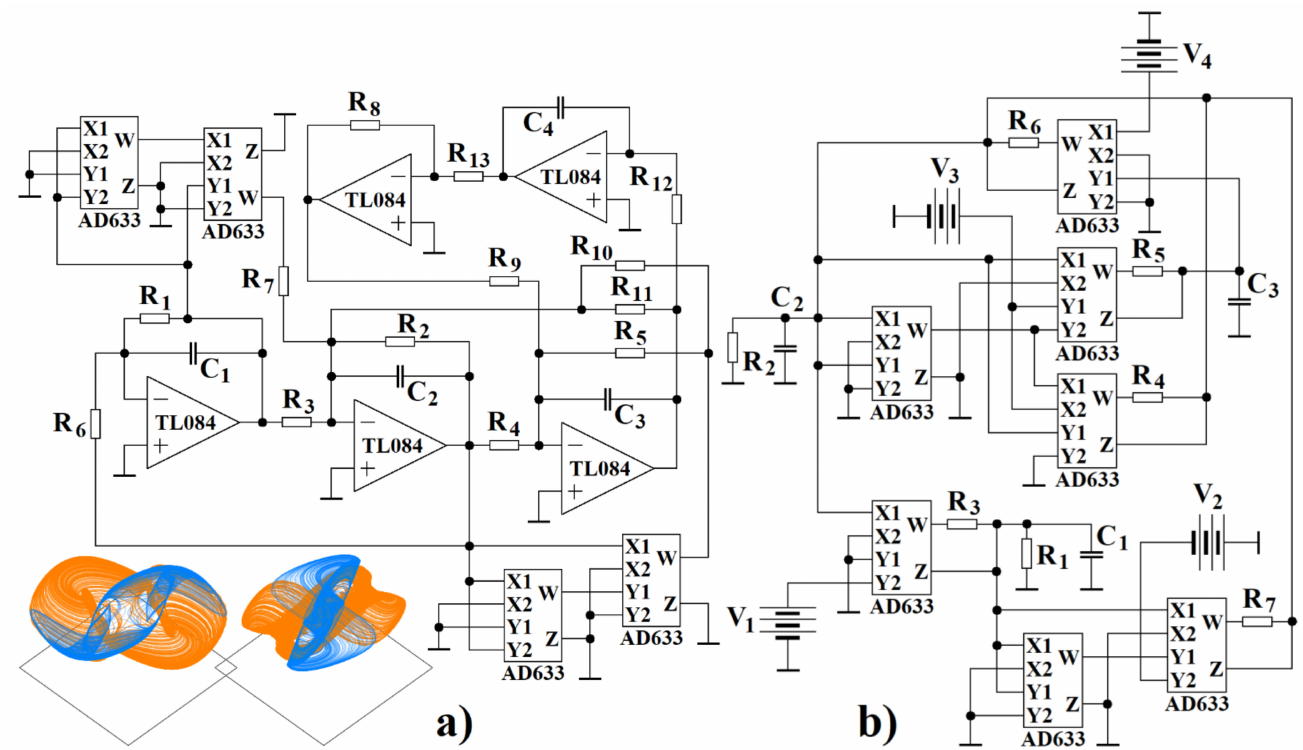
Figure 13. Circuitry realization of cascoded amplifier: ( a ) with resonant load implemented using analog computer concept, ( b ) with resistive load implemented using trans-conductance cells.